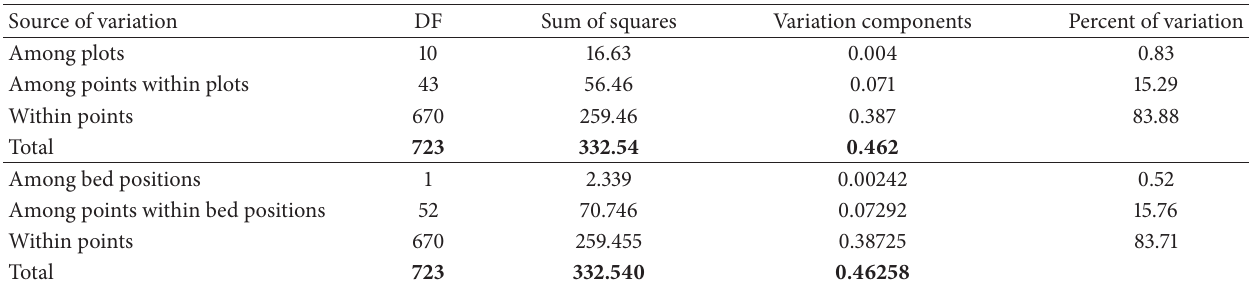
Table 4: AMOVA results for the plot and bed position data sets. Multiply sampled multilocus genotypes were excluded. The majority of the total genetic variation shown in both tables occurs at the finest scale included in the analysis